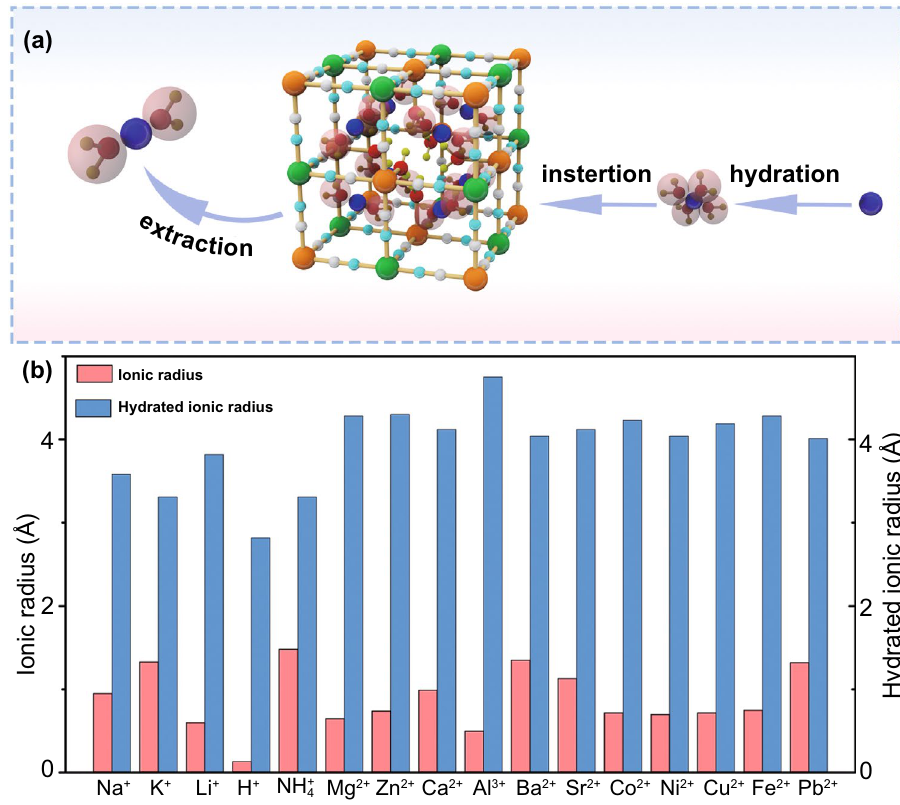
Fig. 3 a Schematic of host ion insertion and extraction in PBAs. b Histogram of ionic radius and hydration radius of various host